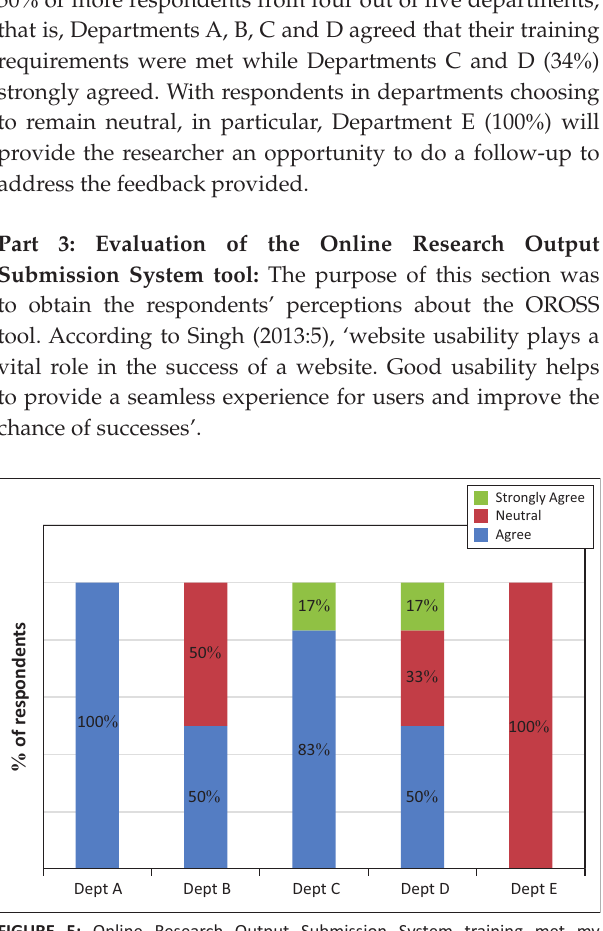
FIGURE 5: Online Research Output Submission System training met my requirements.